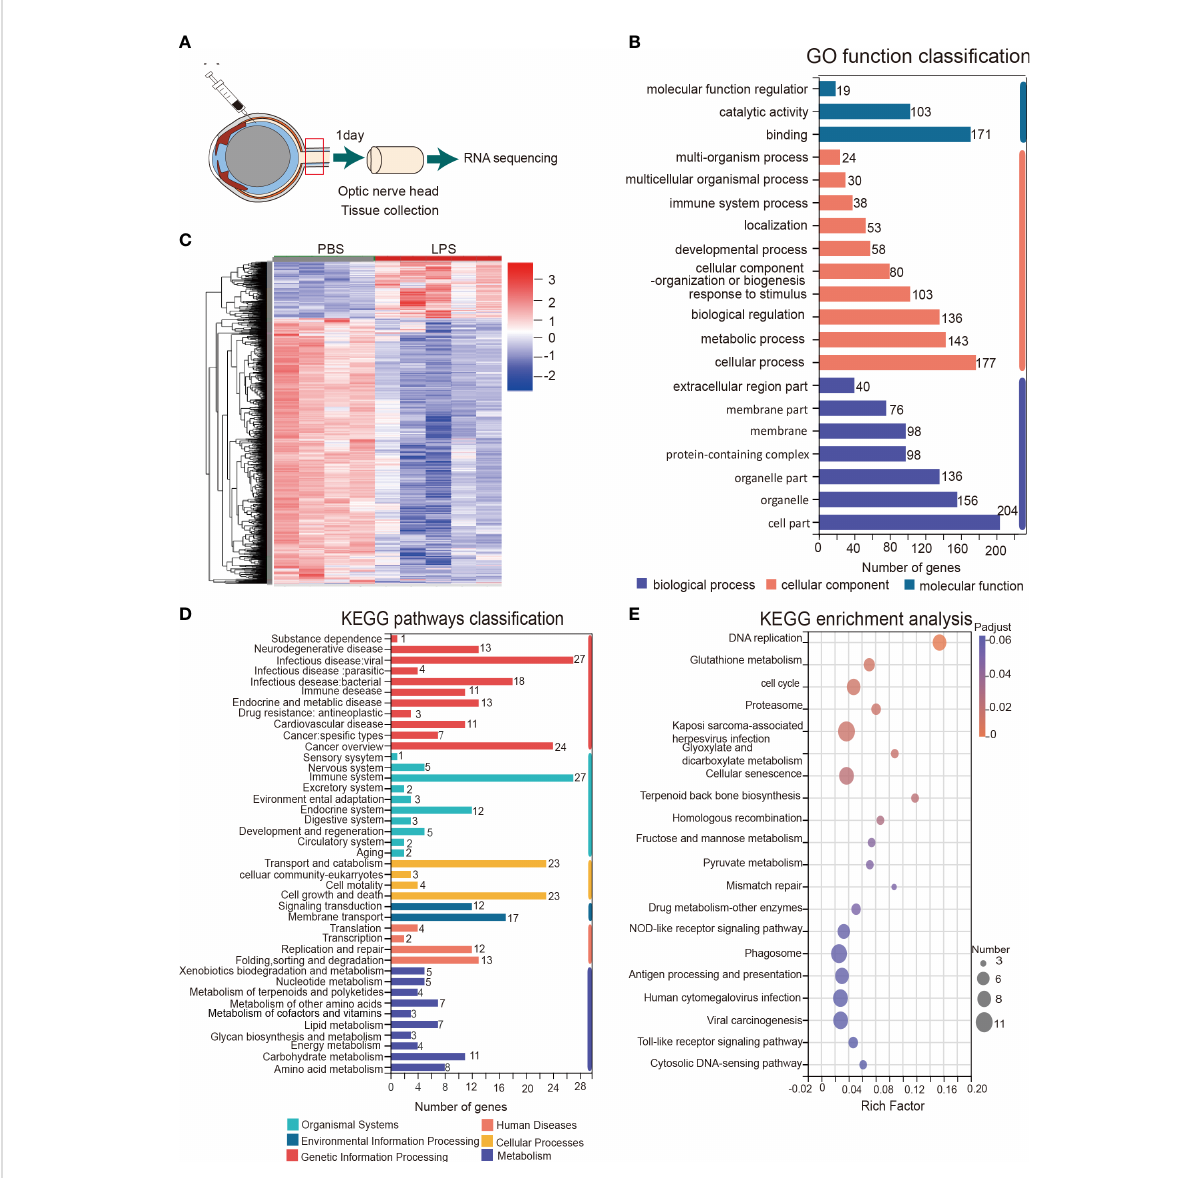
FIGURE 5 KEGG pathway and gene ontology (GO) analysis of the transcriptomes of the ONH on day 1 PII. (A) Schematic illustration of ONH RNA sequencing; n = 4 ONHs for the PBS group and n = 5 ONHs for the LPS group. (B) GO function classi fi cation of the up-regulated differentially expressed genes (DEGs) in the LPS group compared to the PBS group. P-adjust value ≤ 0.01. (C) Cluster heatmap demonstrating the transcriptomic features of DEGs in the PBS and LPS groups. Color scale indicates the normalized expression level of DEGs. (D) KEGG